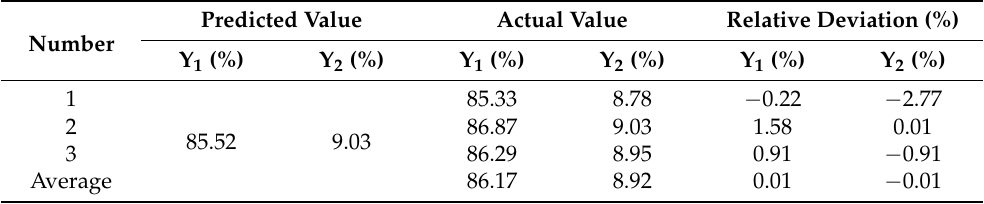
Table 3. Analysis of the significant parameters in the CCD